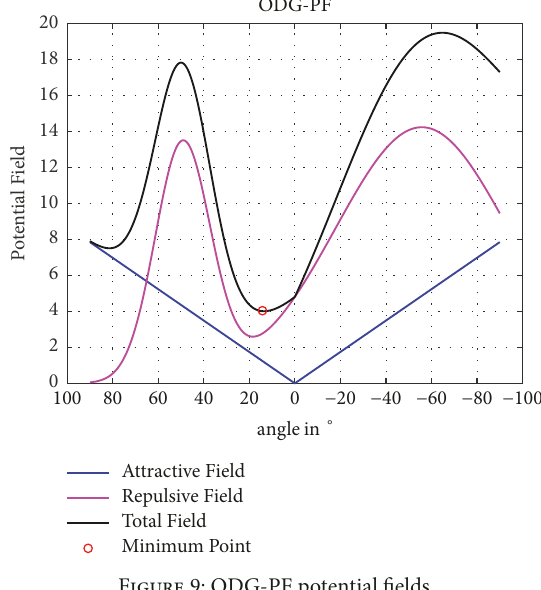
Figure 9: ODG-PF potential